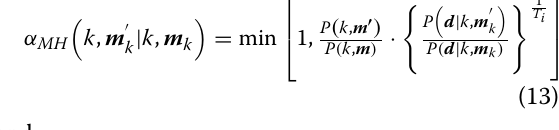
in the frequency domain (e.g., Akuhara and Mochizuki 2015; Yu et al. 2015; Zhang and Olugboji 2021), where h 1 , β 1 , and ρ 1 represent a thickness, Vs, and a density of the overriding sediment layer, respectively; β 2 and ρ 2 repre- sent Vs and a density of the half space; f s represents free- surface reflection; τ represents a two-way travel time of S-wave passing through the sediment layer; and ` S ´ S and S S represent reflection and transmission coefficients at ´ ´ the layer interface, respectively. From Eq. 17, we obtain the denominator of deconvolution without